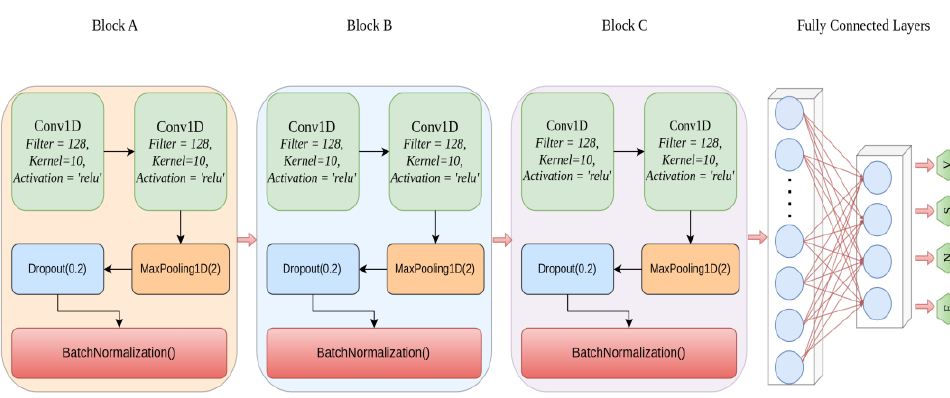
Figure 4. The proposed 1D-CNN model architecture.